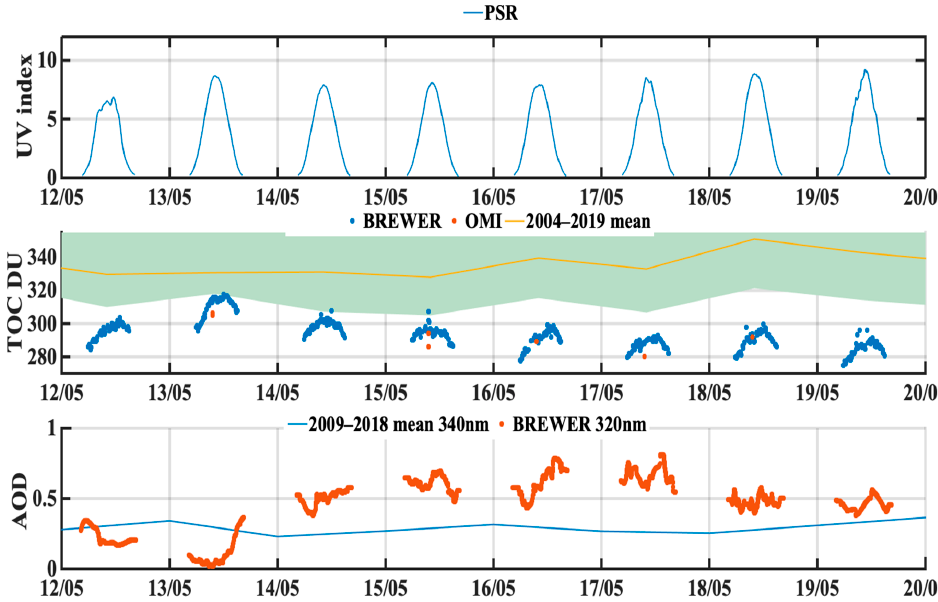
Figure 4. Variation of UVI as retrieved from the PSR measurements ( upper plot). Variation of TOC as retrieved from BRS compared to OMI and average ± 2 σ for the period, derived from BRS 2004–2019 data ( middle plot). AOD at 320 nm as retrieved from BRS along with climatological average AOD at 340 nm as retrieved from AERONET for the period 2009–2018 ( lower